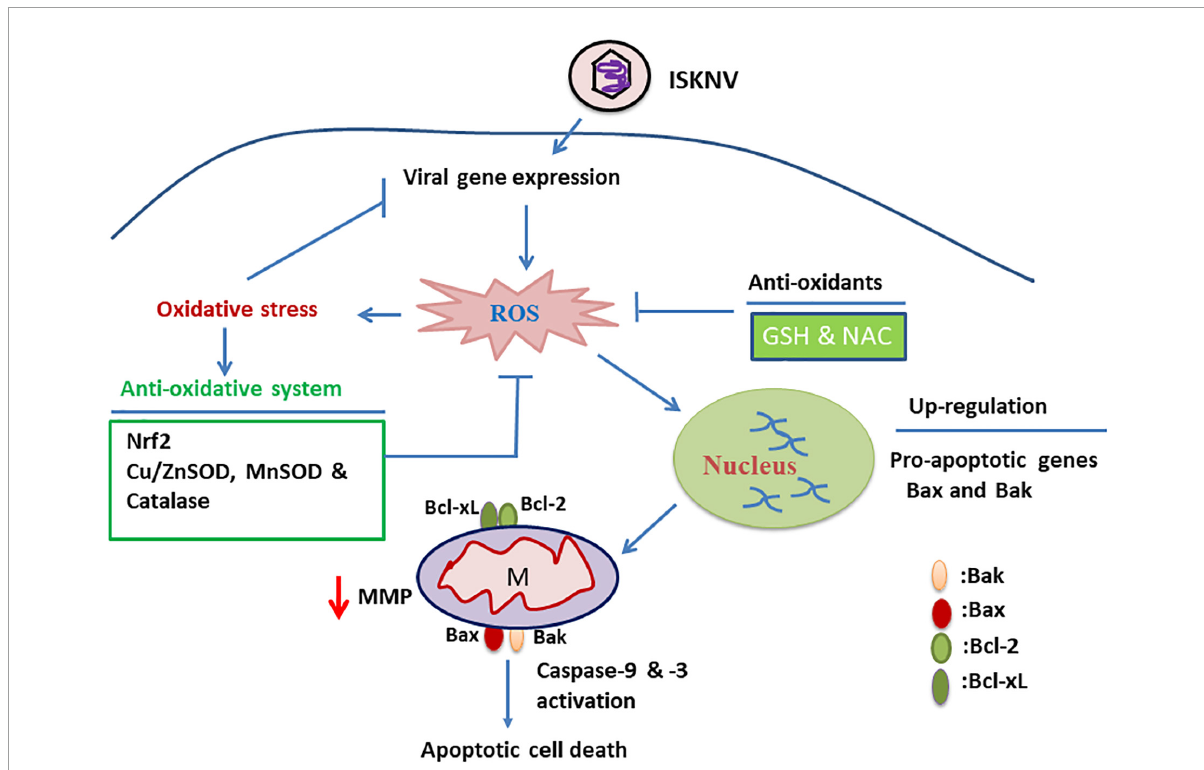
FIGURE7 Hypothetical pathway where infectious spleen and kidney necrosis virus (ISKNV)-triggered reactive oxidative species (ROS)/Nrf2 stress signals either modulate the apoptotic Bax/Bak death pathway or reduce viral replication in fish cells. ISKNV shows a unique approach, using the ROS-mediated stress response that can either upregulate the death factor genes Bax and Bak or induce oxidative stress signals in the early viral replication stages in fish cells. In the ISKNV-induced Bax/Bak cell death pathway, these signals are also connected to changes in mitochondrial function, observed as MMP loss ( (cid:49)(cid:57) m) and caspase-9/-3 activation in fish cells. On the other hand, the oxidative stress response can also upregulate the stress transcriptional factor Nrf2 and antioxidant enzymes, such as catalase, Cu/MnSOD, and ZnSOD, which are correlated with the metabolism of ROS, such as superoxide and hydrogen peroxide, and thus the recovery of biological function in proteins or molecules. We found that the ISKNV-induced ROS/Nrf2-mediated Bax/Bak death pathway and viral replication can be inhibited by treatment with antioxidants such as GSH and NAC, providing a new strategy for viral